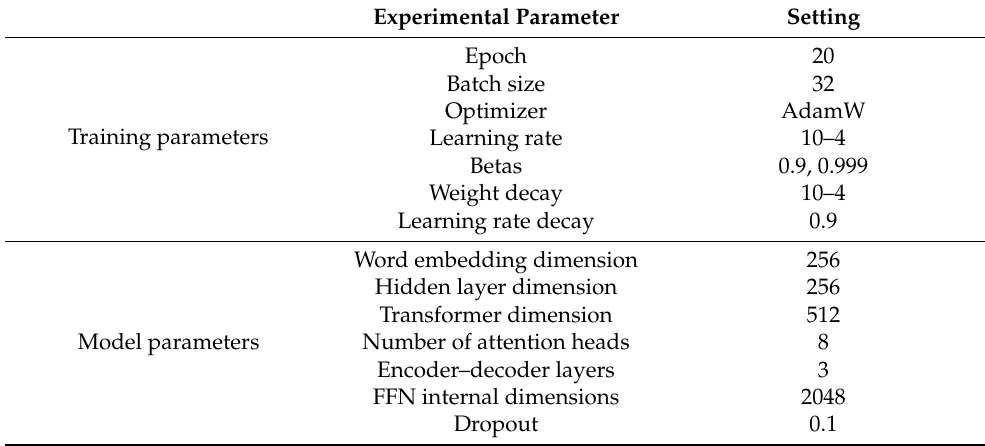
Table 2. Experimental parameter settings.